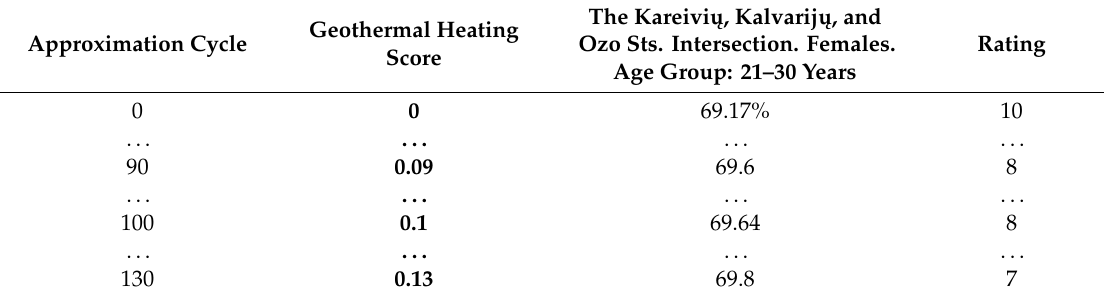
The bold is used for calculations and result